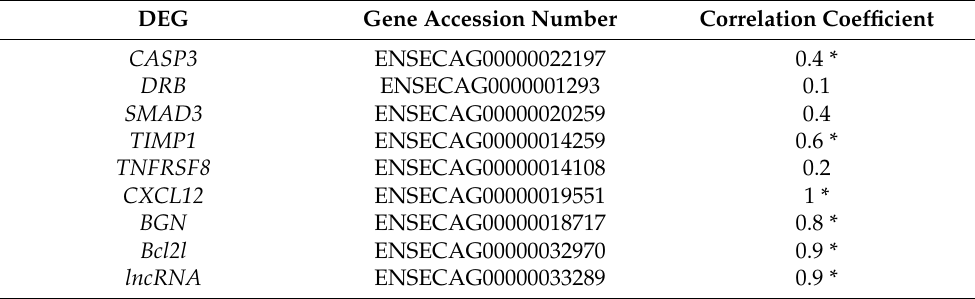
Table 2. Genes’ expression correlation coefficients between Real Time PCR and RNA-seq data obtained for chosen